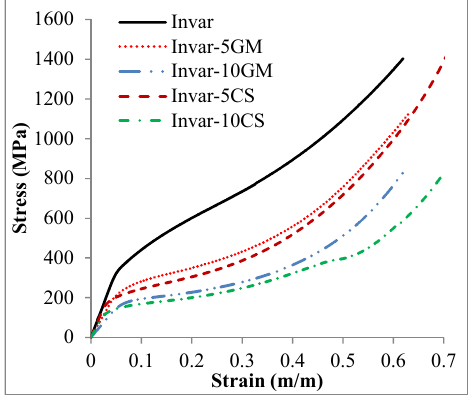
Figure 7. The compressive stress ‐ strain response of Invar steel and its SFs at the strain rate of 10 − 3 s − 1 . The data of Invar and its SFs ‐ filled glass microballoons (GM) is obtained from reference [20].